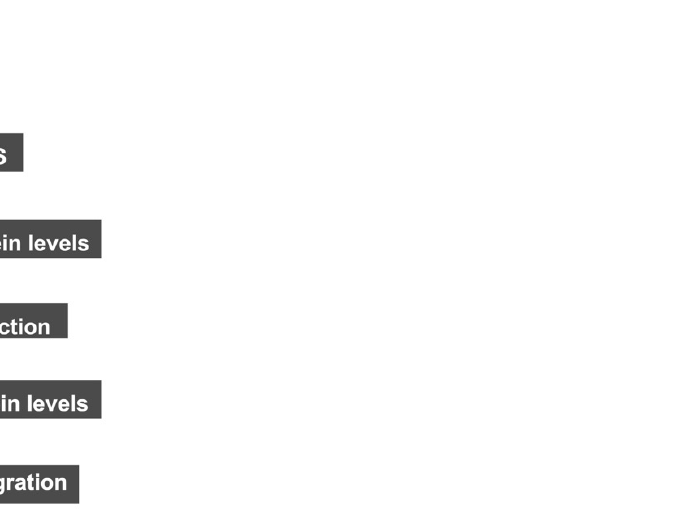
Figure 7. Hypothetical pathway by which sevoflurane decreases mitigation. Sevoflurane triggers the production of reactive oxygen species (ROS) and increases CypD levels to induce mitochondrial dysfunction. Mitochondrial dysfunction leads to a decrease in the levels of DCX, a protein involved in neuronal migration and di ff erentiation, resulting in a decrease in NPCs migration.